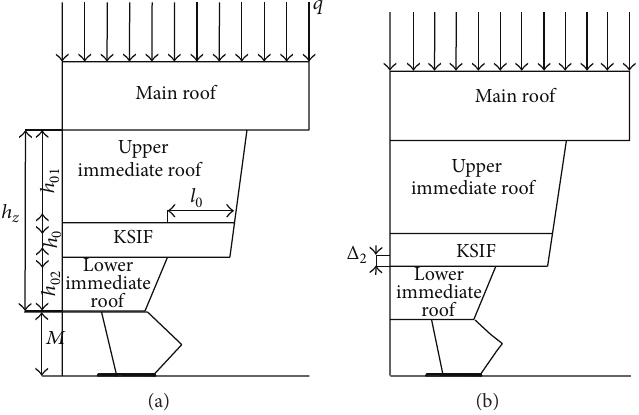
Figure 10: Dynamic load calculation model of